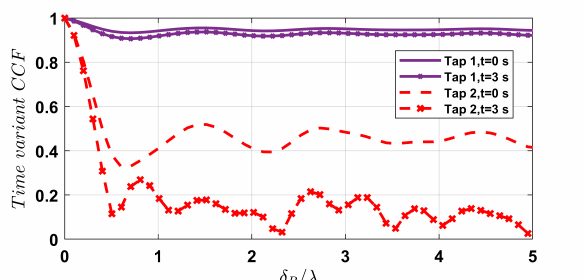
Figure 5. The absolute values of the time-variant space CCF of different taps of the proposed HST channel model at different time instants.